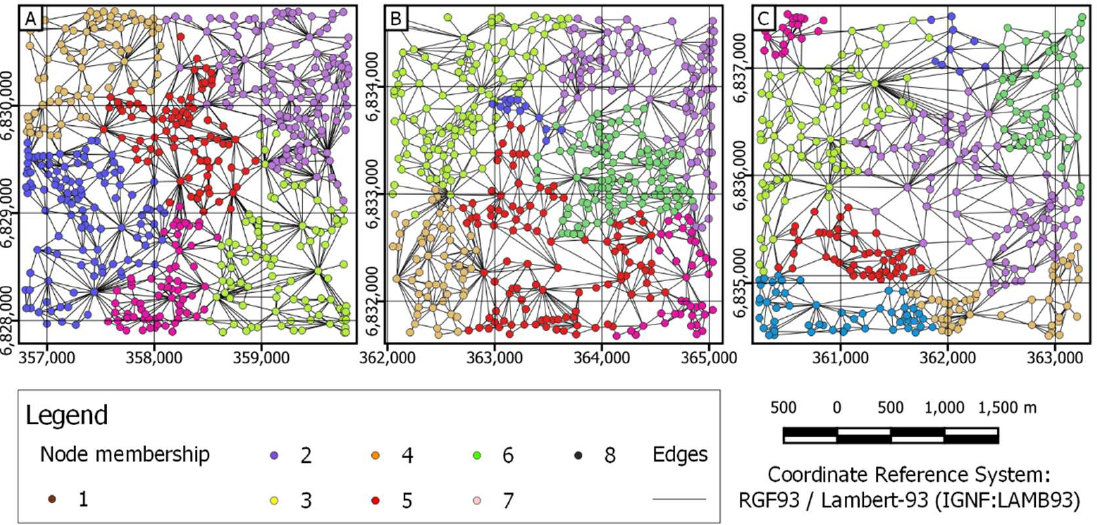
Figure 3. Graphs representing communities in landscapes ( A – C ) in the Zone Atelier Armorique. Each color represents a different community (from 1 to 8) based on greedy optimization of modu- larity.